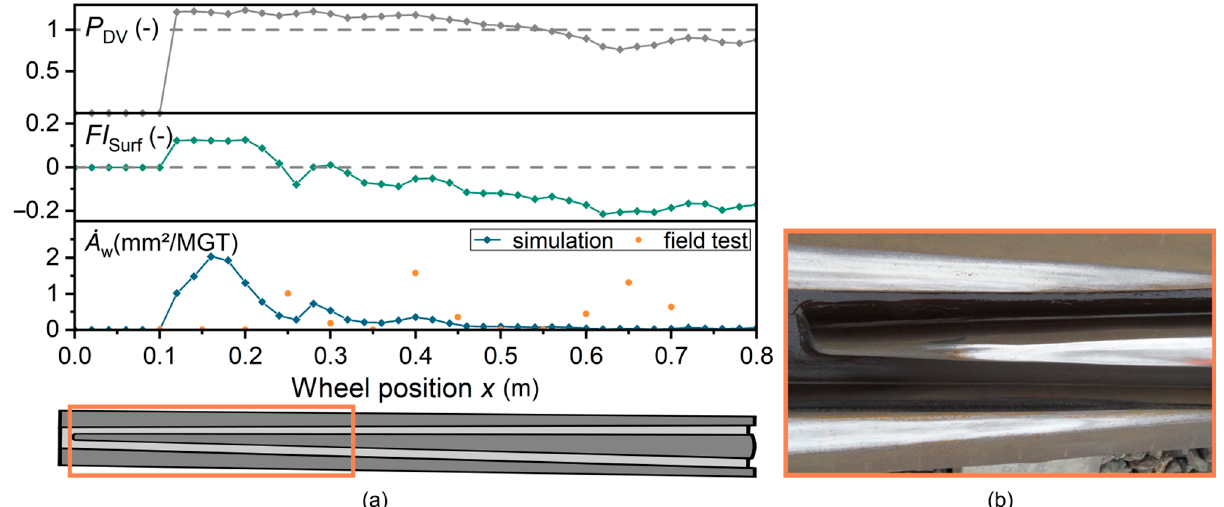
Figure 16. RCF and wear predictions for a simplified traffic scenario assuming an even distribution of the new, worn and hollow wheels over 1 MGT traffic presented in an assessment diagram: ( a ) local distribution of damage indices including the wear area rate ( Ȧ w ) from field measurements reported in [13] and ( b ) photograph of the monitored manganese crossing nose after 19.2 MGT traffic with no visible cracks at the surface provided by voestalpine Railway Systems GmbH, Leoben, Austria.